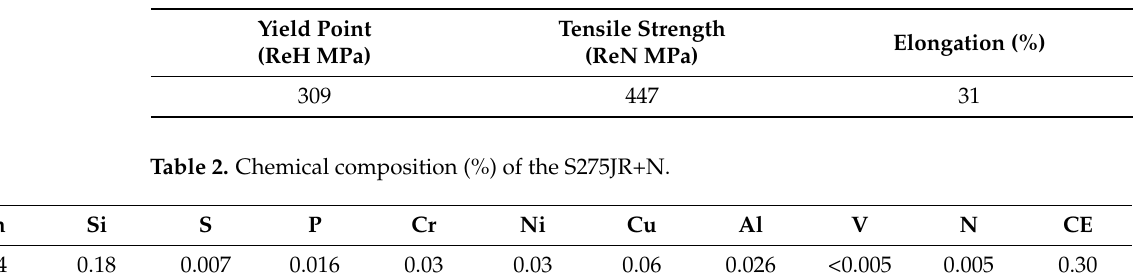
Table 1. Mechanical properties of the S275JR+N.